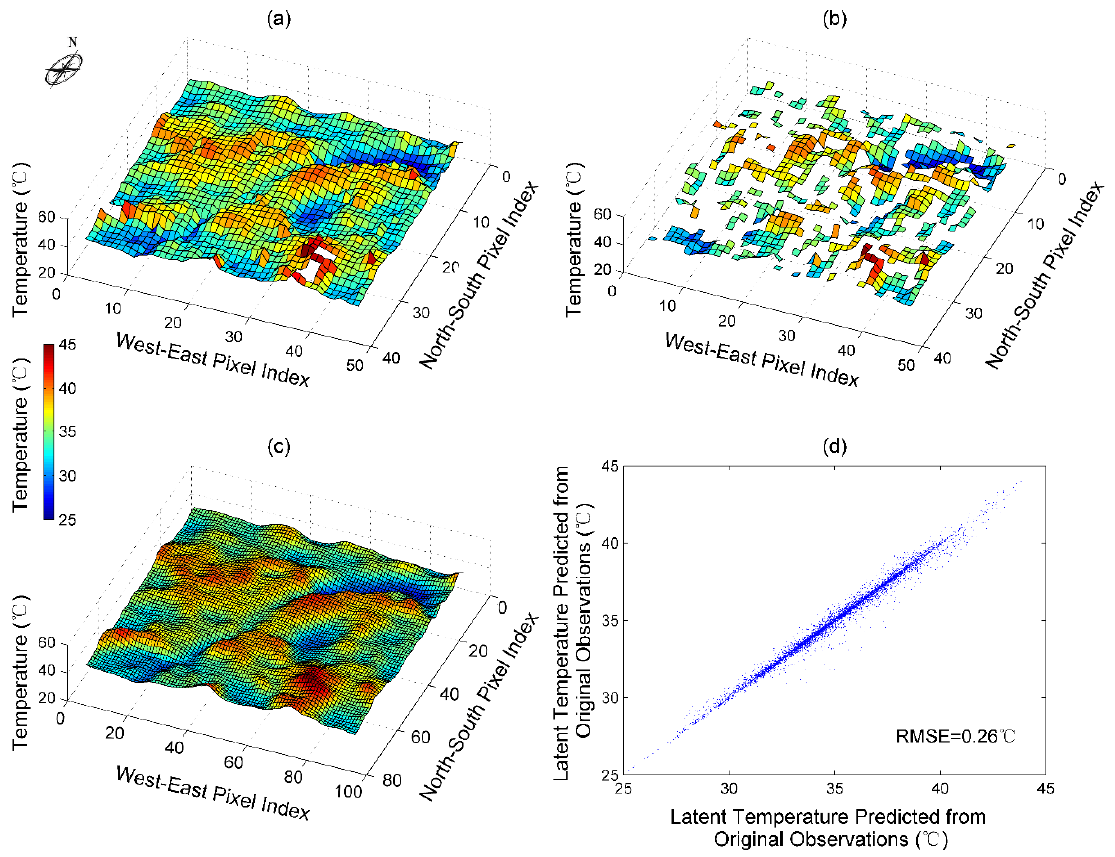
Figure 4. Robust test of the latent LST recovery. ( a ) The original image at 13:30 on 27 July 2012; ( b ) The manipulated image with more missing pixels; ( c ) The recovered continuous latent LST pattern; ( d ) Accuracy assessment of the recovered image by using the data recovered from the non-manipulated image.